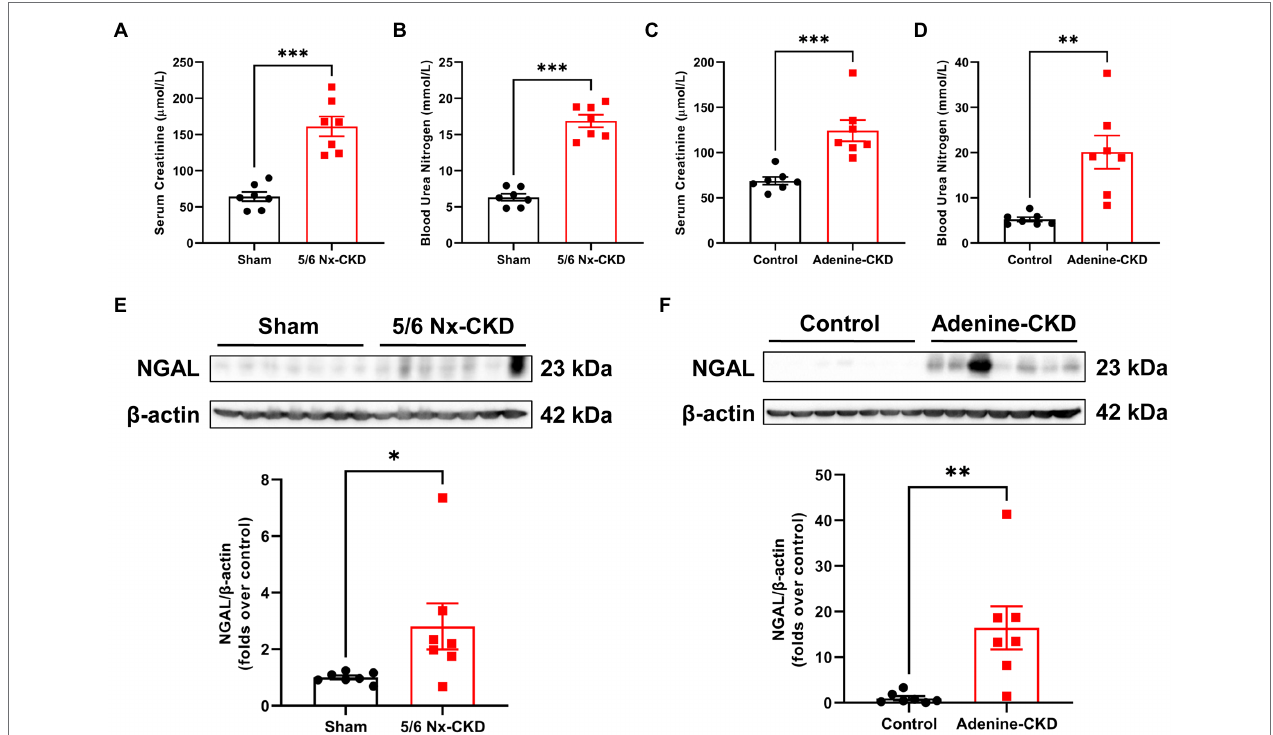
FIGURE 1 | Biochemical analysis of renal function indexes. (A) The serum creatinine (Scr) levels in sham and 5/6 Nx-induced chronic kidney disease (CKD) rats. (B) The blood urea nitrogen (BUN) levels in sham and 5/6 Nx-induced CKD rats. (C) The Scr levels in control and adenine-induced CKD rats. (D) The BUN levels in control and adenine-induced CKD rats. (E) Western blot images and densitometric analysis of NGAL expression in the kidney of sham and 5/6 Nx-induced CKD rats. (F) Western blot images and densitometric analysis of NGAL expression in the kidney of control and adenine-induced CKD rats. Data are presented as the means ± SEM, n = 7 rats per group ( * p < 0.05, ** p < 0.01, and *** p < 0.001 between the indicated two